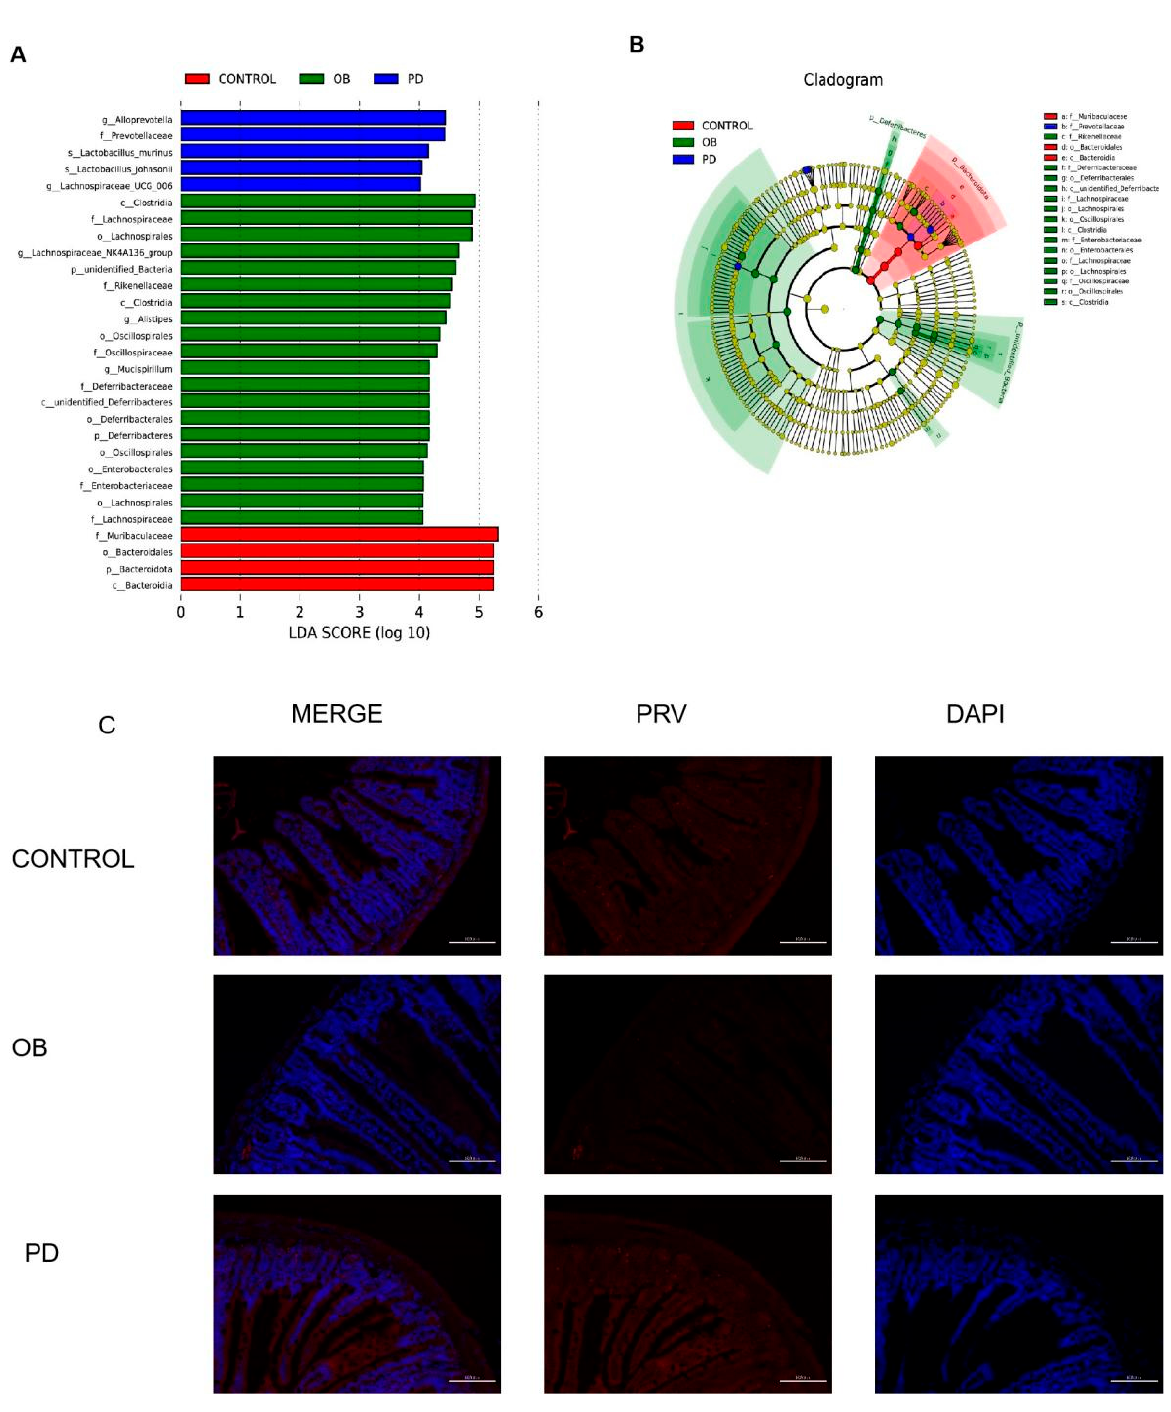
Figure 5. Key Phylotypes Responding to the PD Treatment in ob/ob Mice ( A ) Linear discriminant analysis (LDA) scores were computed for taxa with differential abundance in the fecal microbiota of CONTROL, OB and PD. The LDA score indicated the effect size and ranking of each differentially abundant taxon (LDA > 4); ( B ) Taxonomy cladogram. The circle of radiation from inside to outside represented the taxonomic rank from phylum to genus (or species) and the diameter of the circles was based on relative abundance; ( C ) In situ hybridization (ISH) staining (200×) (Prevotella).